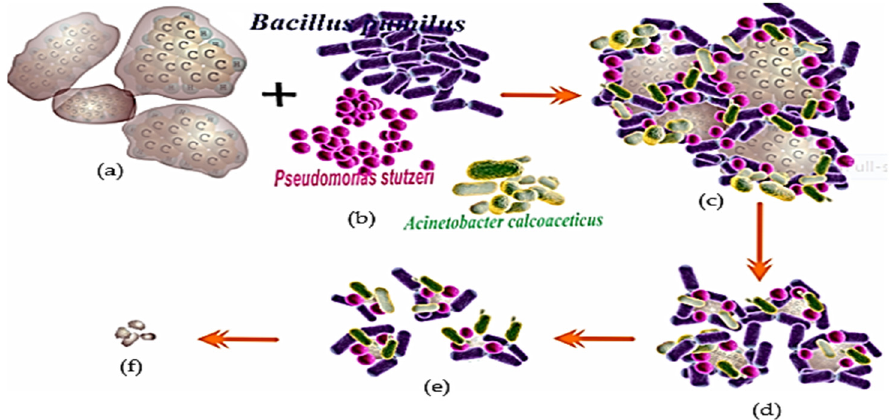
Figure 6. The process of the biodegradation of PAH contaminants uses a consortium of hydrocar- bonoclastic bacteria. An illustration, bacterial consortium biodegradation of pyrene: ( a ) Pyrene substrate; ( b ) consortium of bacterial degraders (hydrocarbonoclastic); ( c ) Complex of consortium bacterial-pyrene; ( d ) Pyrene begins to degraded; ( e ) Pyrene is significantly degraded and ( f ) A small portion of pyrene is not degraded and the bacterial consortium population has died [58,99,110,113,116].